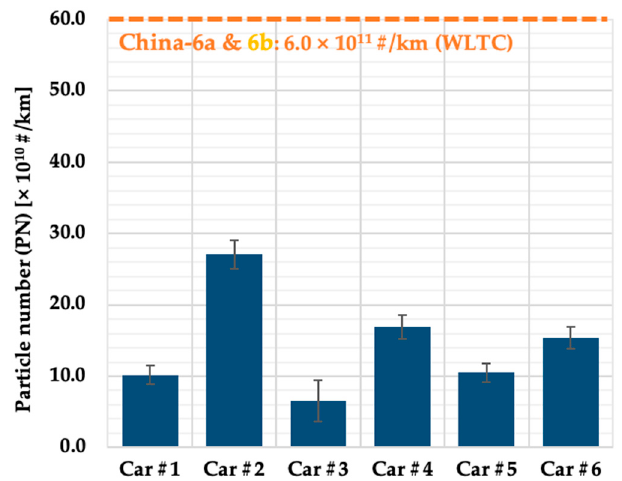
Figure 6. Particle number (PN) emissions from the in-use methanol taxis.